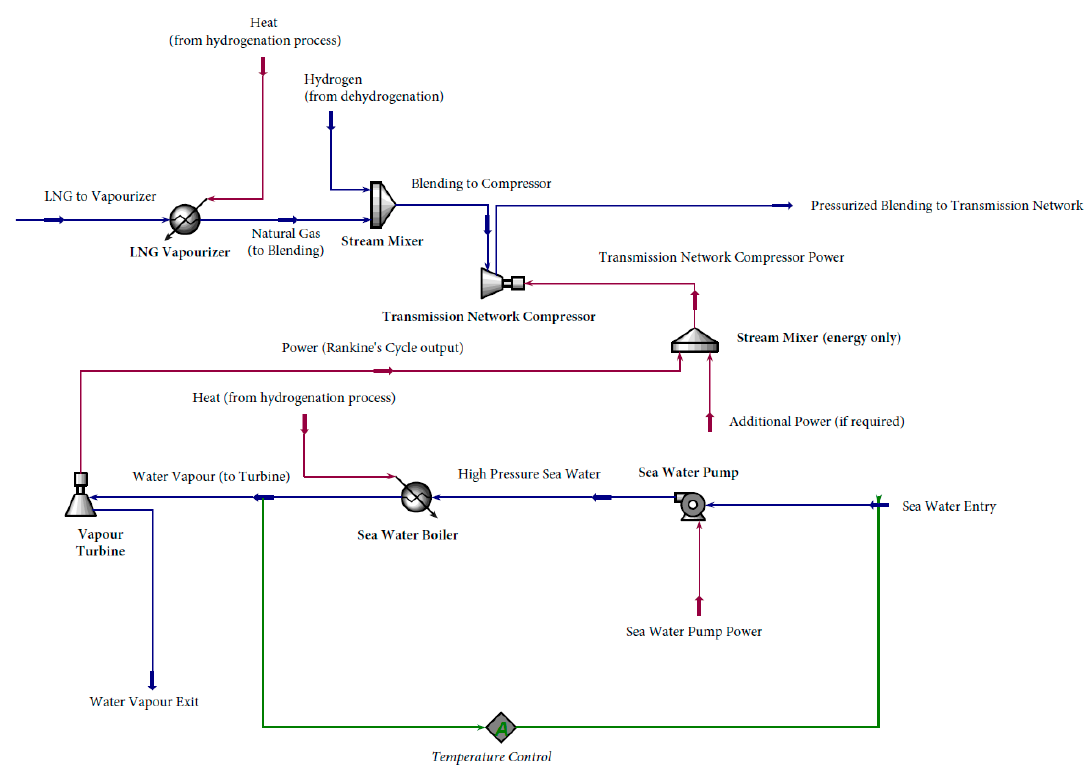
Figure 8. Simulated PFD for the energy integration system.